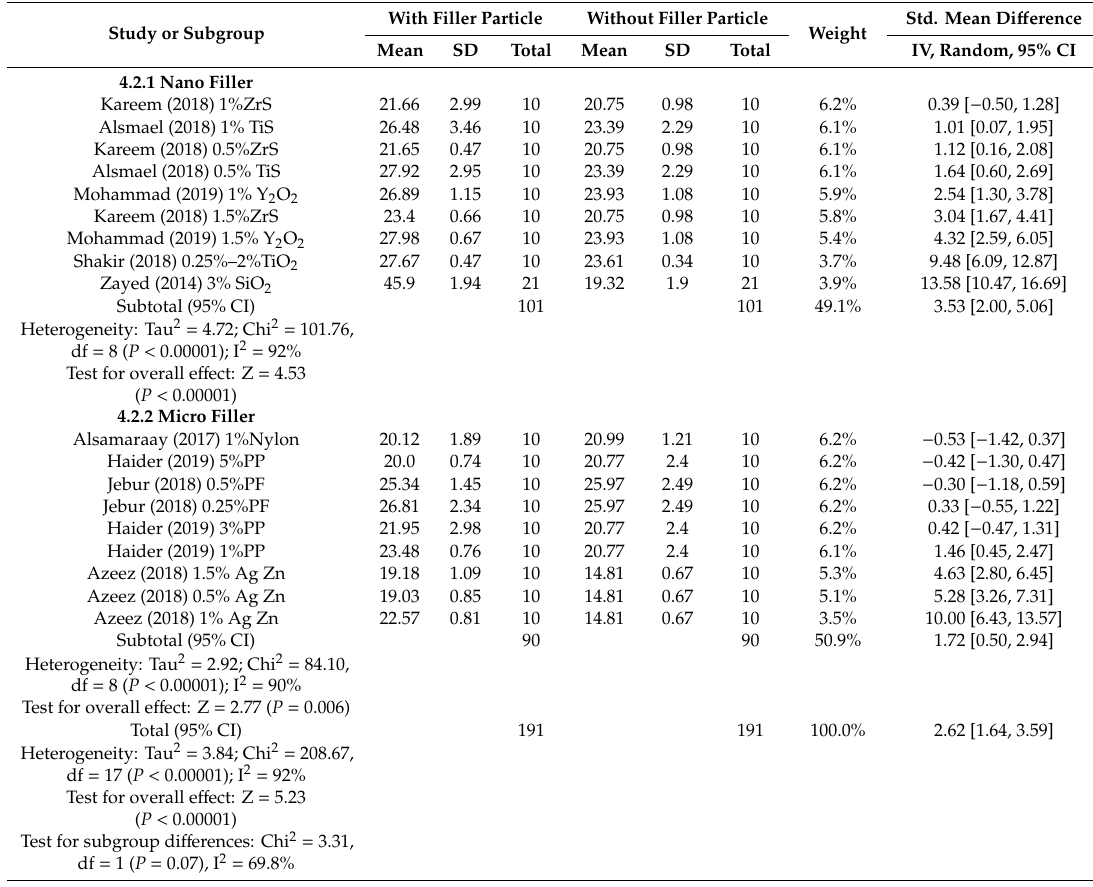
Table 6. Subgroup analysis and forest plot of tear strength (N / mm) studies.